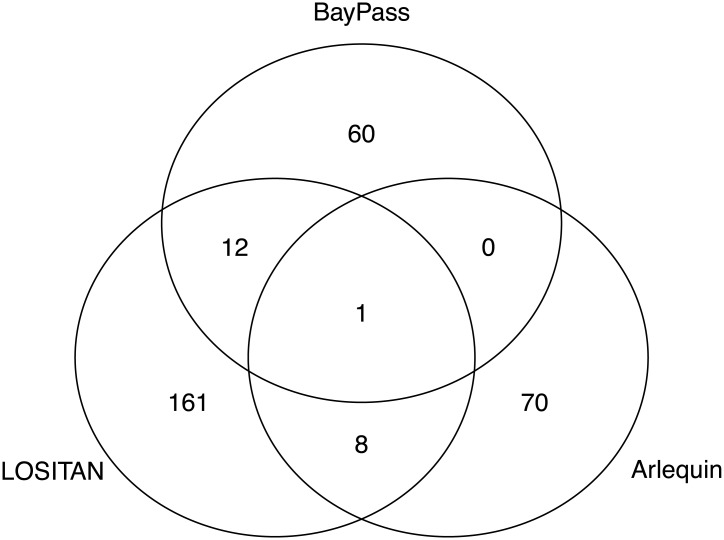
Overlap between outlier SNPs.Venn diagram of all significantly differentiated SNPs detected with Arlequin (p < 0.05), LOSITAN (p < 0.05) and BayPass (top 5% XTX values).